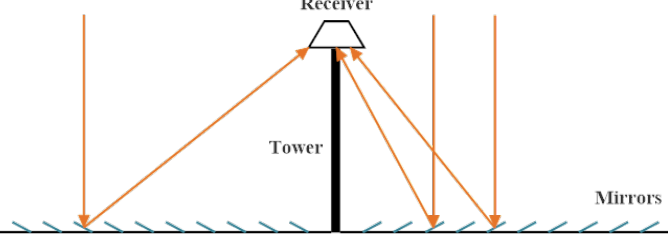
Figure 1. Linear Fresnel reflector with a central receiver. Adapted from reference [17].